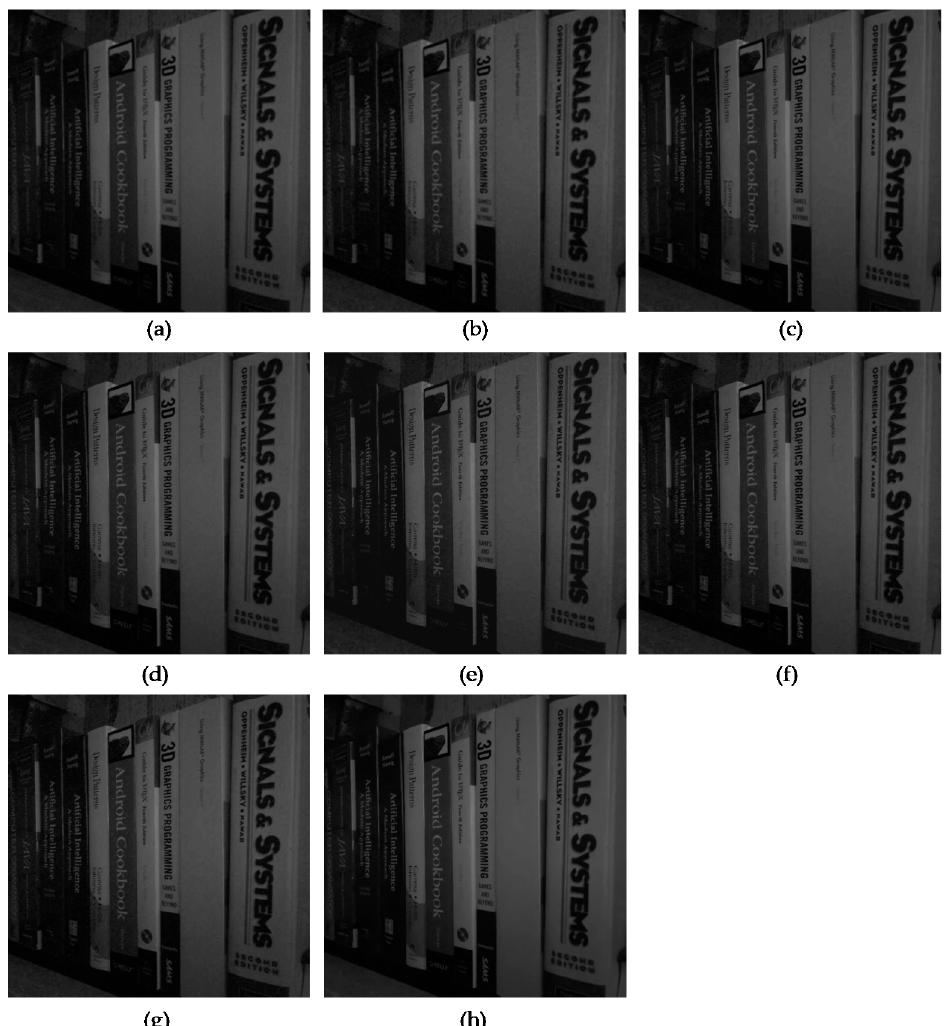
Figure 8. Comparison of the subjective visual quality for the image from the SIDD dataset, Books. ( a ) Captured image using an iPhone 7 with ISO = 800 and exposure = 1/2000 (BRISQUE = 43.36). ( b ) JPEG-coded image with q = 30 (BRISQUE = 41.97). ( c ) Result of BM3D [22] (BRISQUE = 45.06). ( d ) Result of SSRQC [23] (BRISQUE = 37.01). ( e ) Result of ARCNN [2] (BRISQUE = 33.15). ( f ) Result of DnCNN [4] (BRISQUE = 33.09). ( g ) Result of MWCNN [5] (BRISQUE = 37.65). ( h ) Result of SCENet (BRISQUE = 25.55).